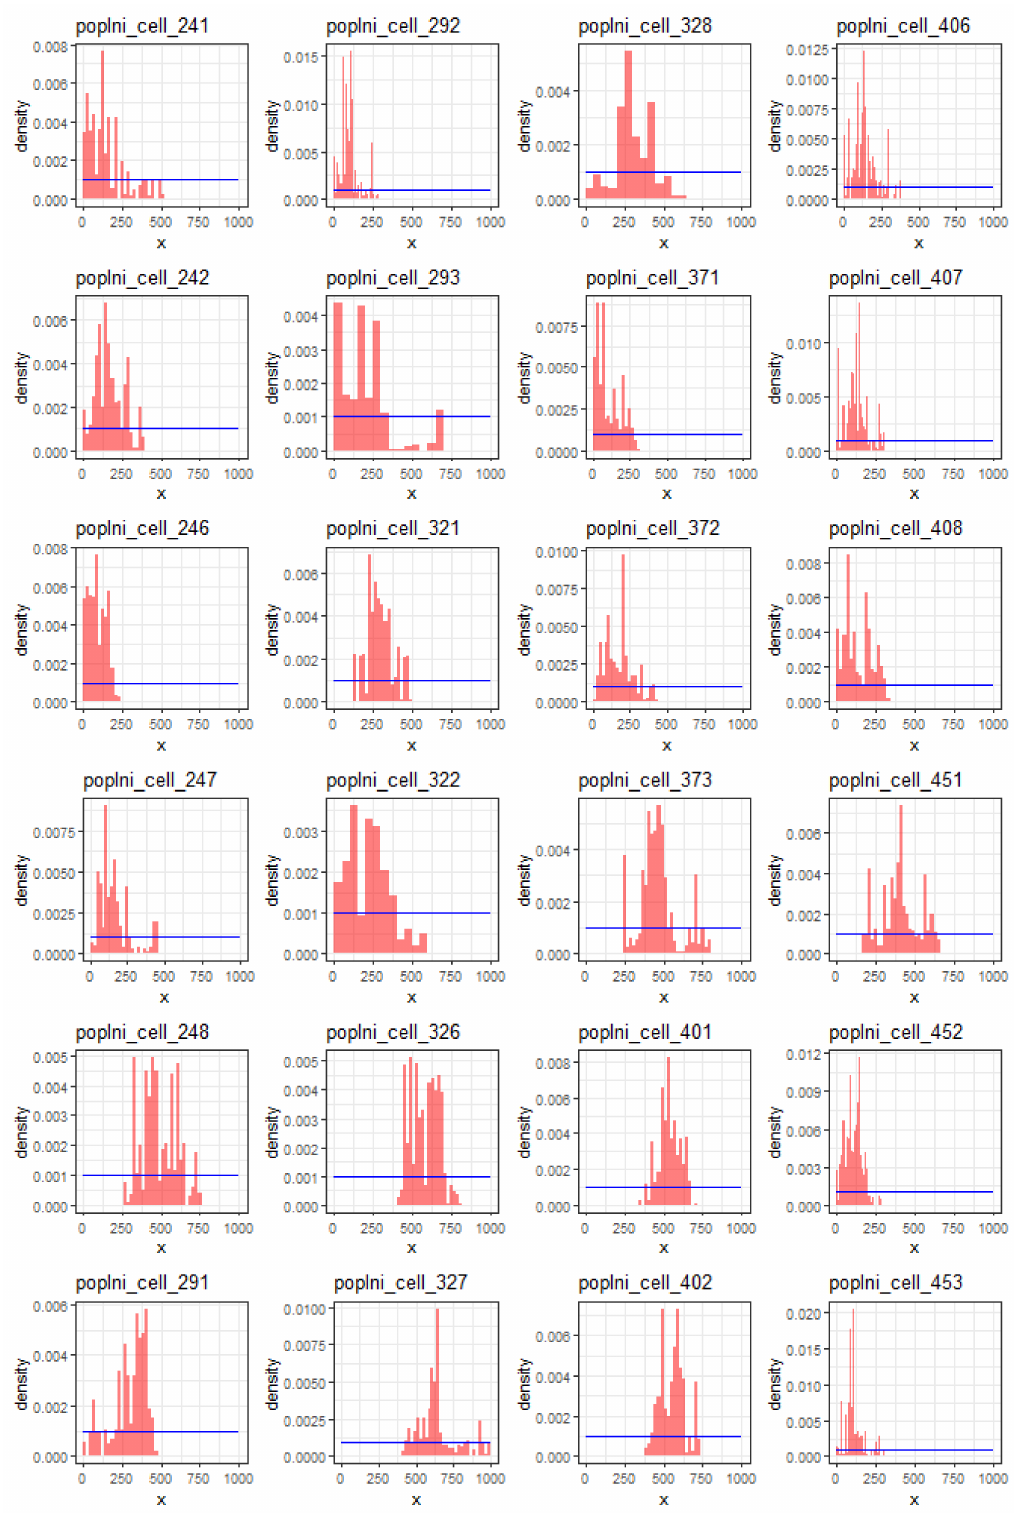
Figure A5. Posterior sample density (red histogram) and prior density (blue curve) for the initial population size ( popIni ) in 1980 for each introduction cell. The mean posterior sample value of a cell is used as the cell value in Figure 1—top of the main